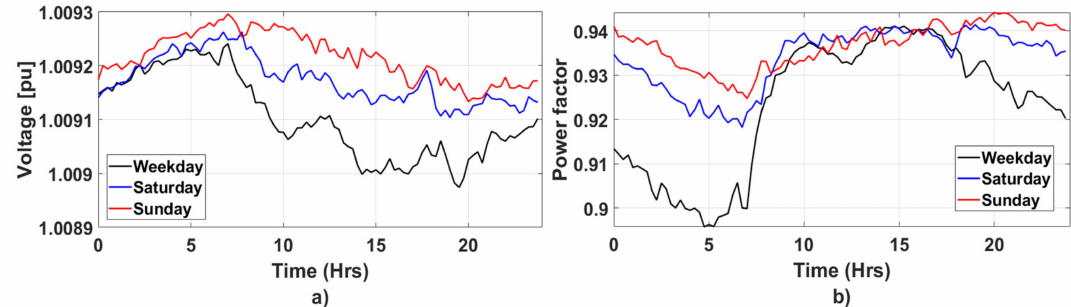
Figure 16. ( a ) Measured voltage curve at the substation-feeder coupling bus; ( b ) Measured power factor curve at the substation-feeder coupling bus.